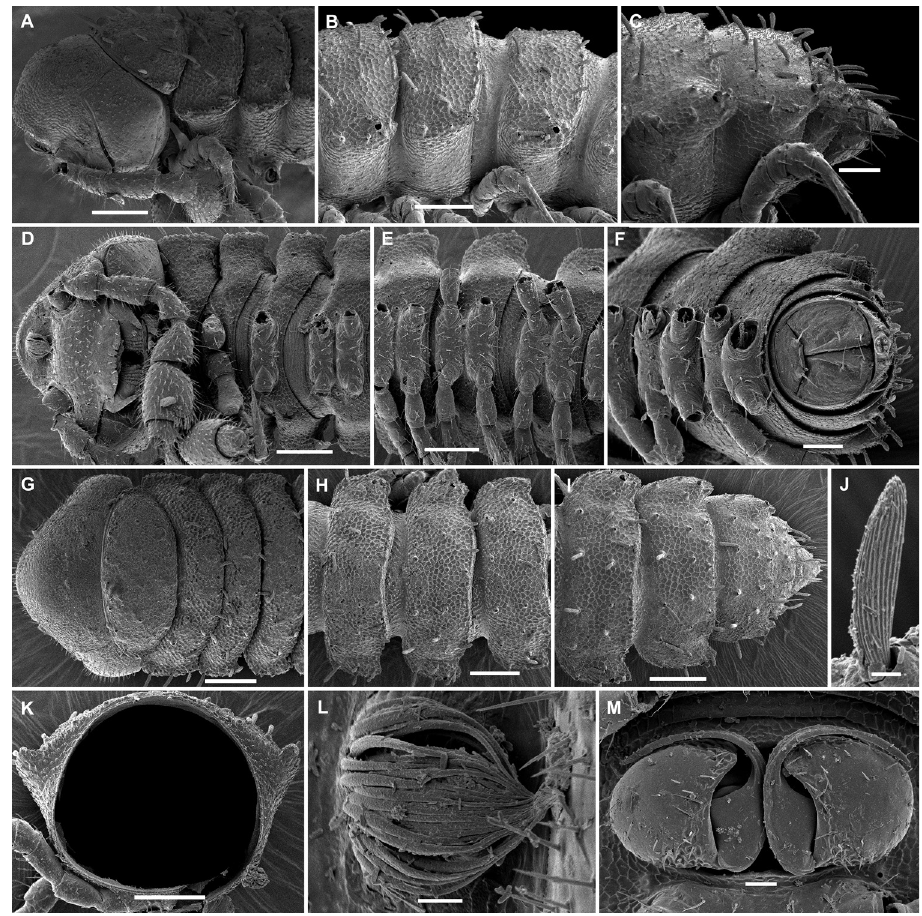
Figure 23. Hemisphaeroparia falcata sp. n., SEM micrographs of ♂ paratype A, D, G anterior part of body, lateral, ventral and dorsal views, respectively B, E, H midbody segments, lateral, ventral and dorsal views, respectively C, F, I posterior part of body, lateral, ventral and dorsal views, respectively J tergal seta, lateral view K midbody segment, caudal view L epicranial tubercle with filaments M both gonopods in situ, ventral view. Scale bars: 0.1 mm ( A, B, D, E, G–I, K ), 0.05 mm ( C, F ), 0.02 mm ( M ), 0.01 mm ( L ), 0.005 mm ( J